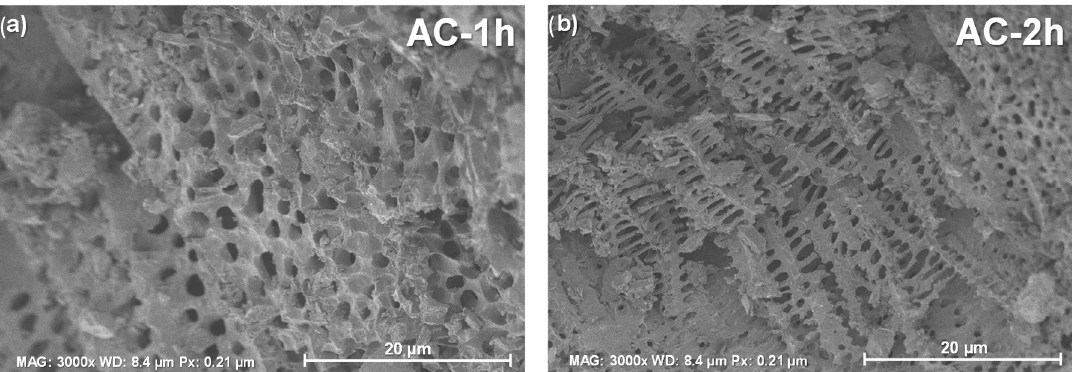
Figure 4. SEM images of the oxidized carbon samples; ( a ) AC-1h and ( b ) AC-2h.